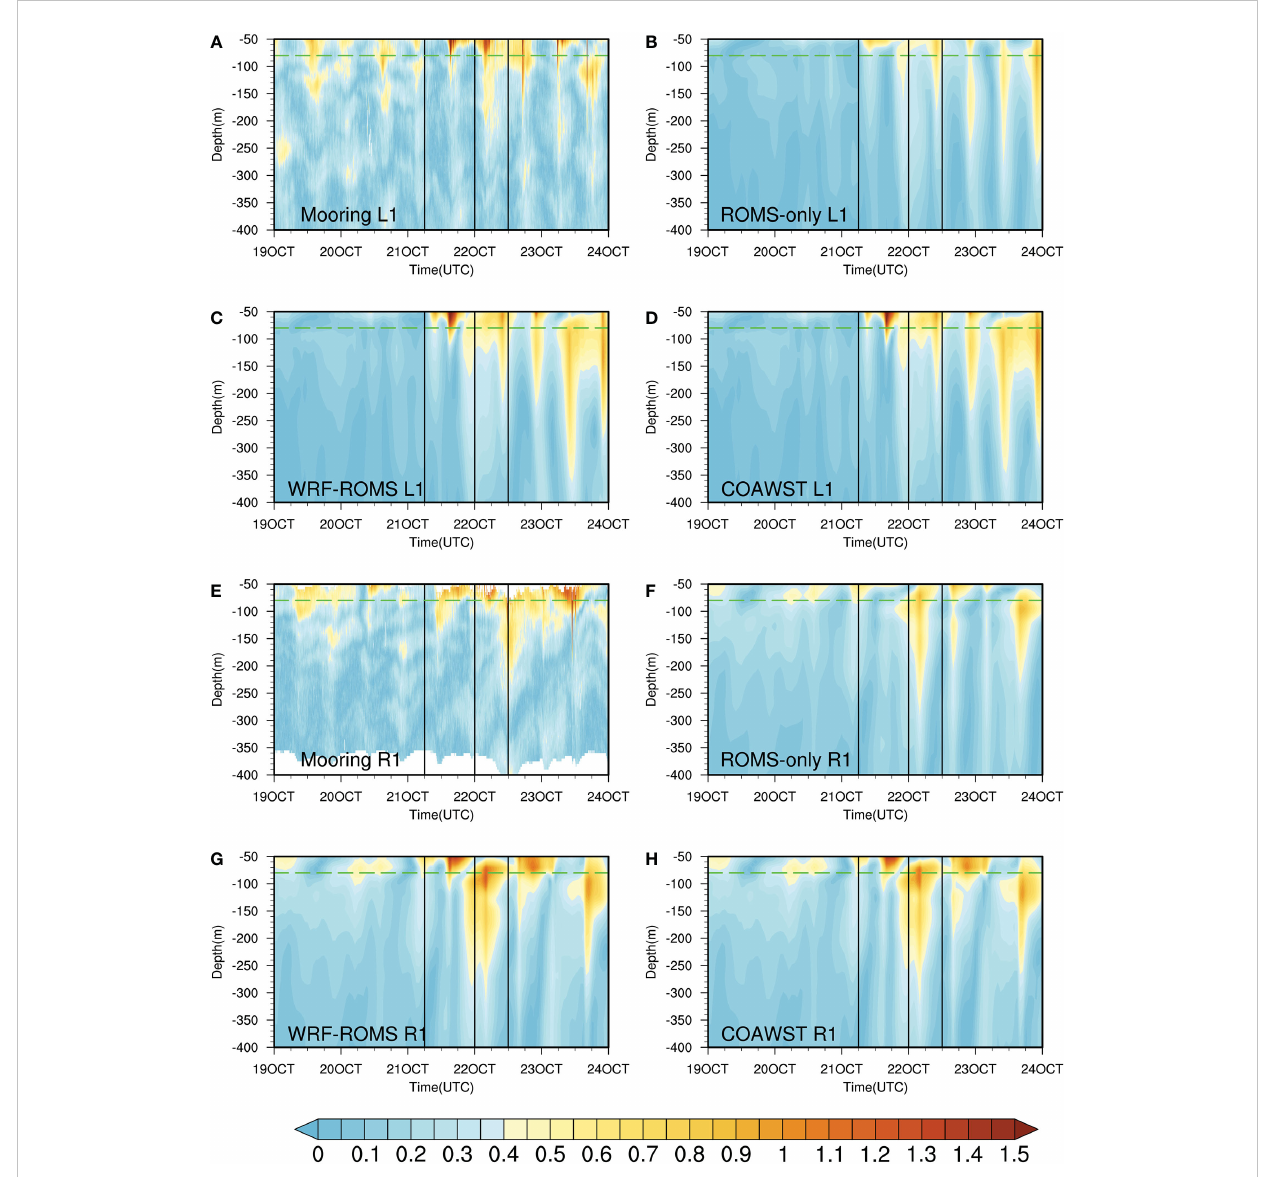
FIGURE 7 Comparison of contours of raw current velocity between observation and simulation at the position of (A – D) mooring L1 and (E – H) mooring R1 versus time and depth. Vertical lines indicate the times during Megi ’ s approaching, arriving, and passing